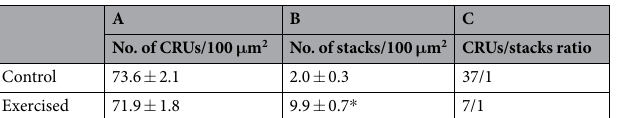
were double-labeled in immunofluorescence experiments (Fig. 3) as follow: RyR1 vs. STIM1 (Fig. 3A,D), RyR1 vs. Orai1 (Fig. 3B,E), and STIM1 vs. Orai1 (Fig. 3C,F). The staining of RyR1 was used as a known reference point marking the position of CRUs (i.e. triads): in adult fibers, triads were located at the A-I band junction on both sides of Z lines to form a double set of transverse cross striations, marked as RyR1-positive puncta (red signal in Fig. 3A,D). In resting muscle, STIM1 was local- ized throughout the entire I band region, with peaks of the green STIM1 signal of variable intensity (Fig. 3A).